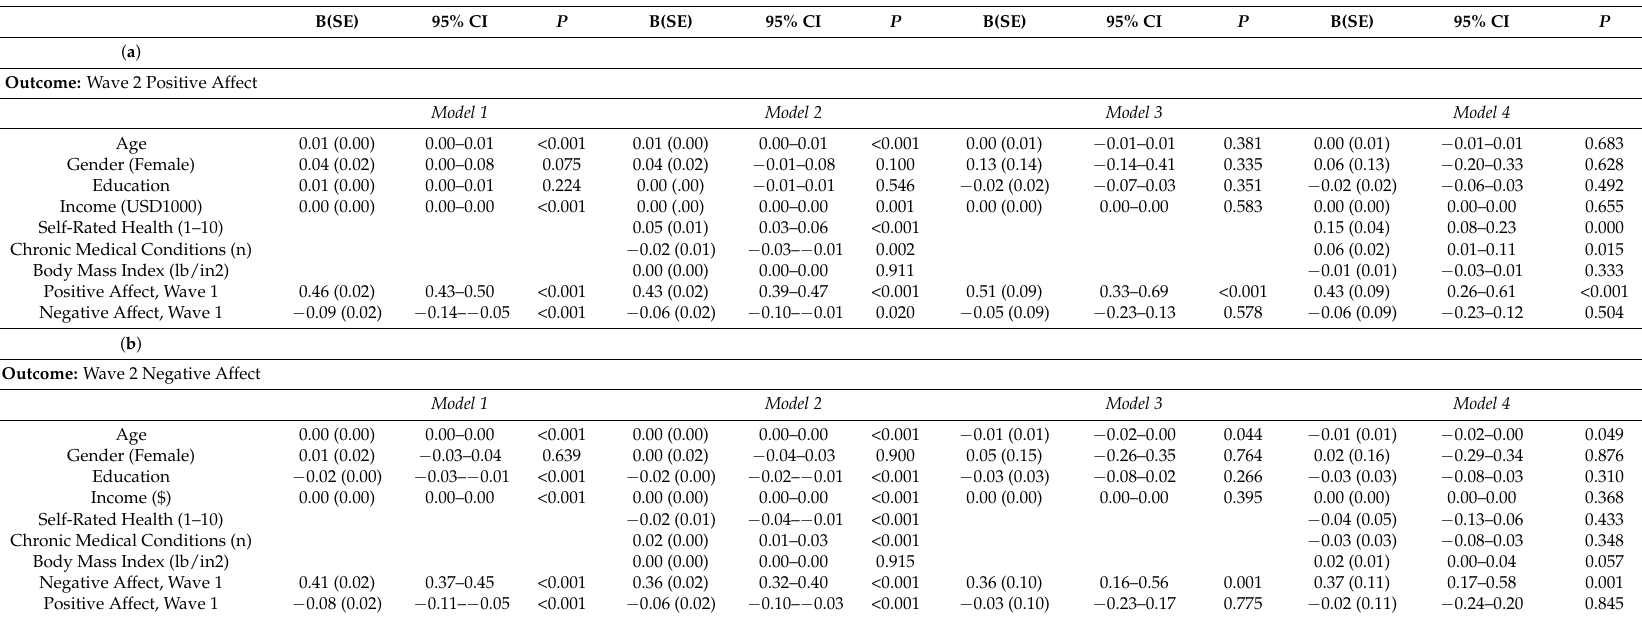
Table 6. Predictors of wave 1 positive and negative affect in White and Black